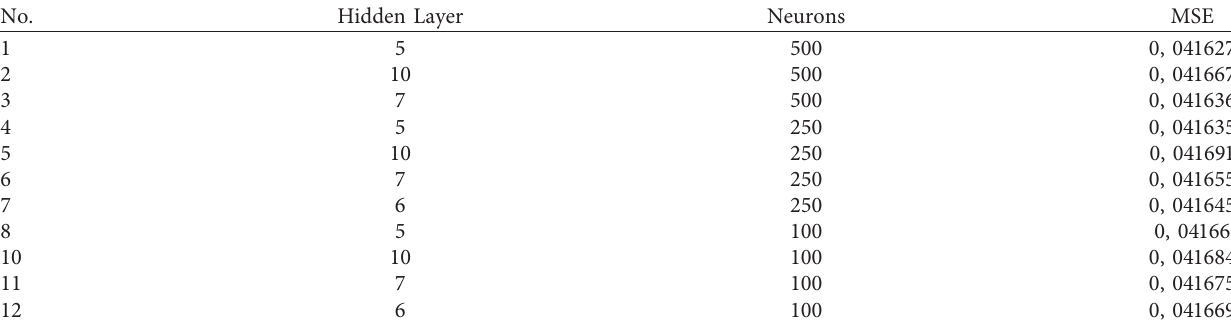
Table 5: The hidden layers comparison.